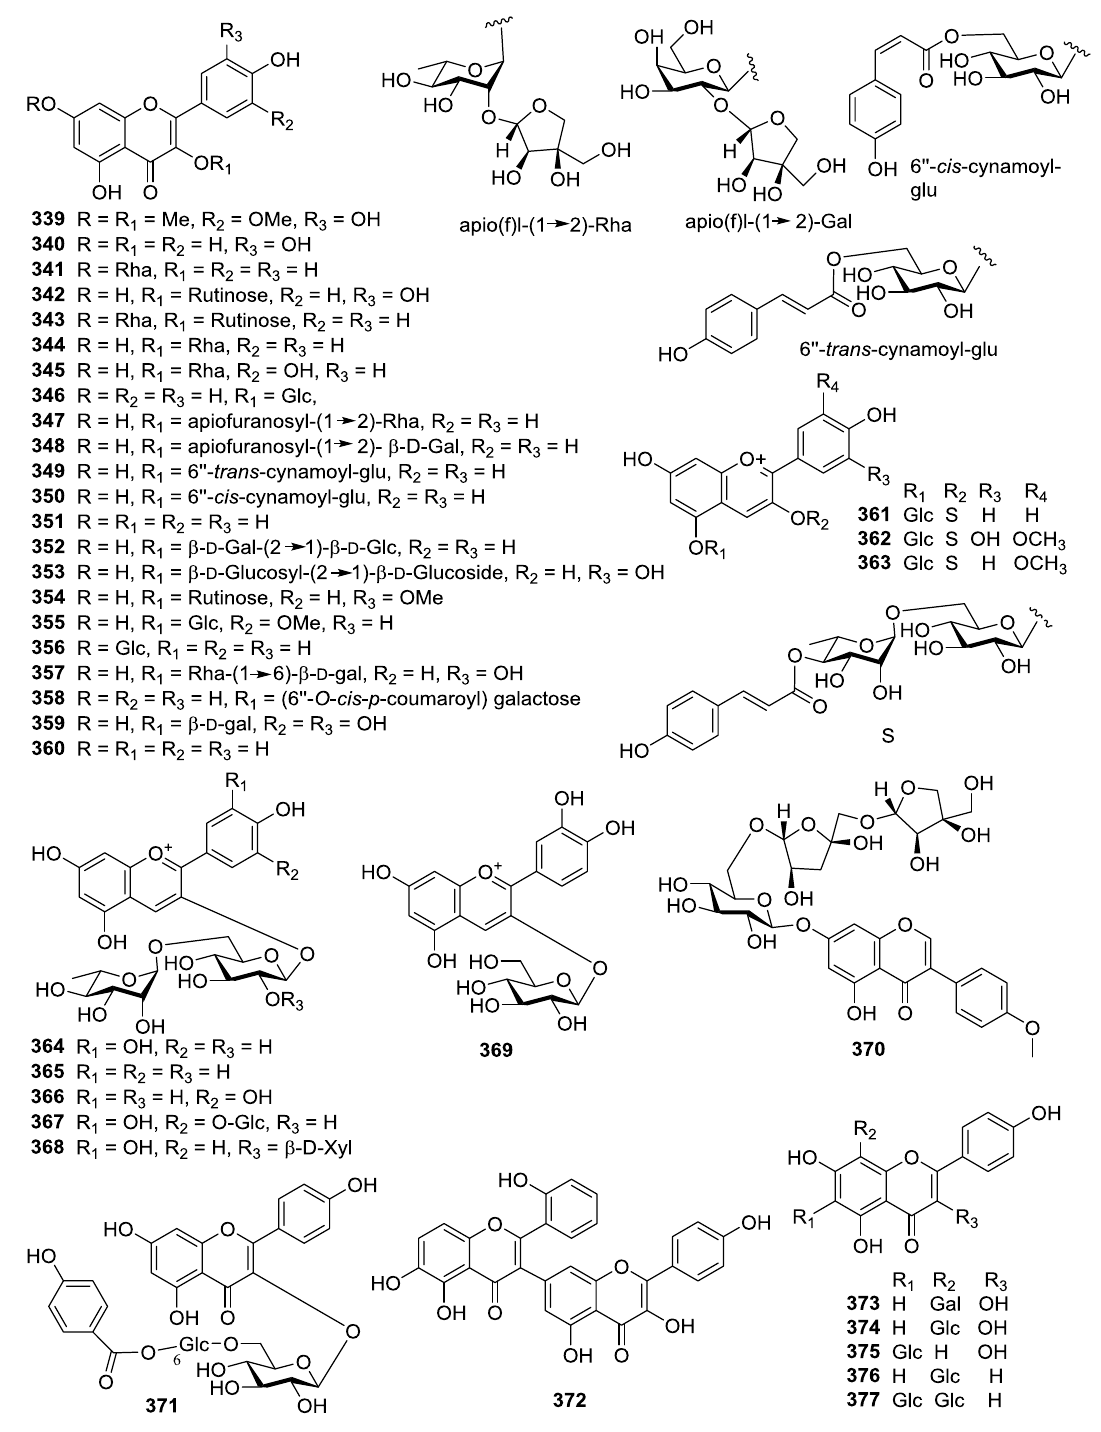
Fig. 8 Flavonoids 339 – 413 from